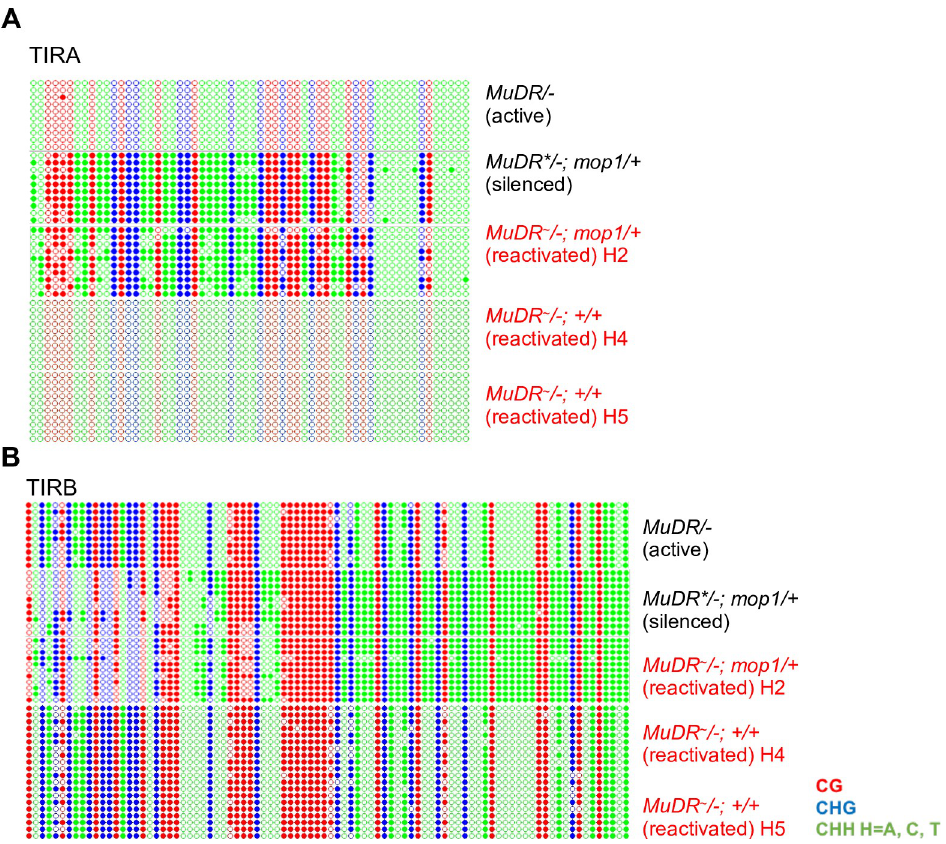
Fig 7. DNA methylation patterns at TIRA and TIRB in H 2 , H 4 and H 5 progeny of heat-treated plants. (A) DNA methylation patterns at TIRA. (B) DNA methylation patterns at TIRB. Ten individual clones were sequenced from each amplification of bisulfite-treated sample. The cytosines in different sequence contexts are represented by different colors (red, CG; blue, CHG; green, CHH, where H = A, C, or T). Red text indicates plants derived from heat-treated plants. MuDR � refers to a silenced MuDR element. MuDR ~ refers to a reactivated element. For each assay, six independent samples were pooled